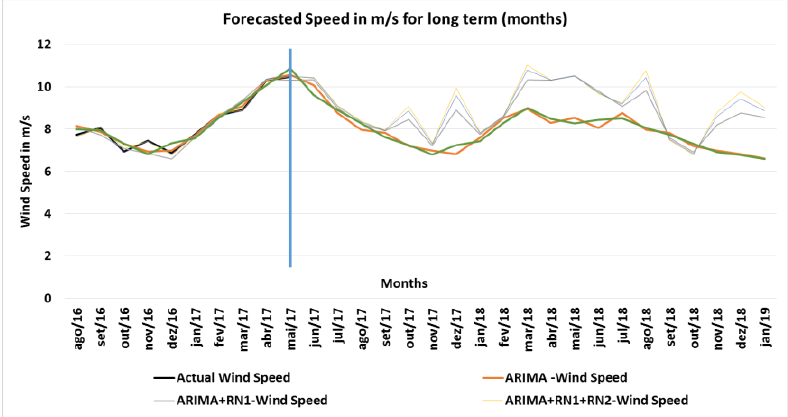
Figure 16. Estimated speed for long-term forecast (months) in m/s.